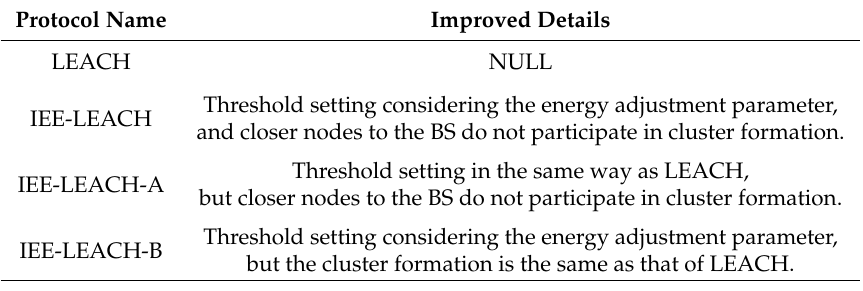
Table 2. Comparison of the improvement schemes of the proposed routing protocols.